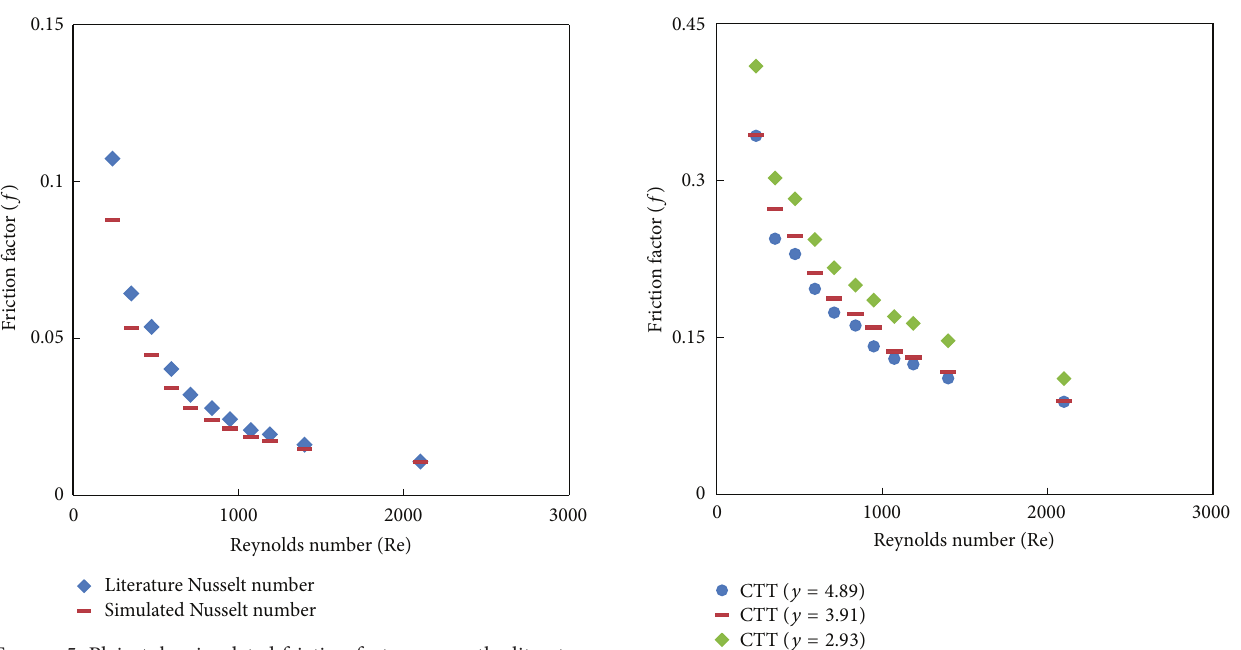
Figure 7: Simulated friction factor of twisted tape with different twist ratios ( 𝑦